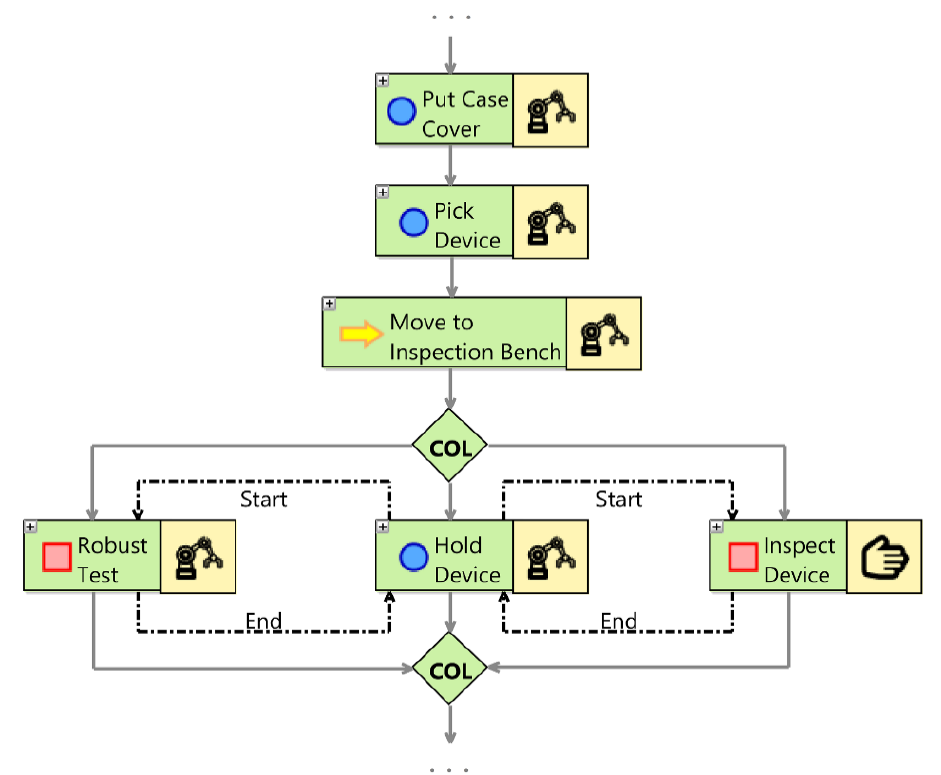
Figure 7. An extract from the orchestrated production process model.